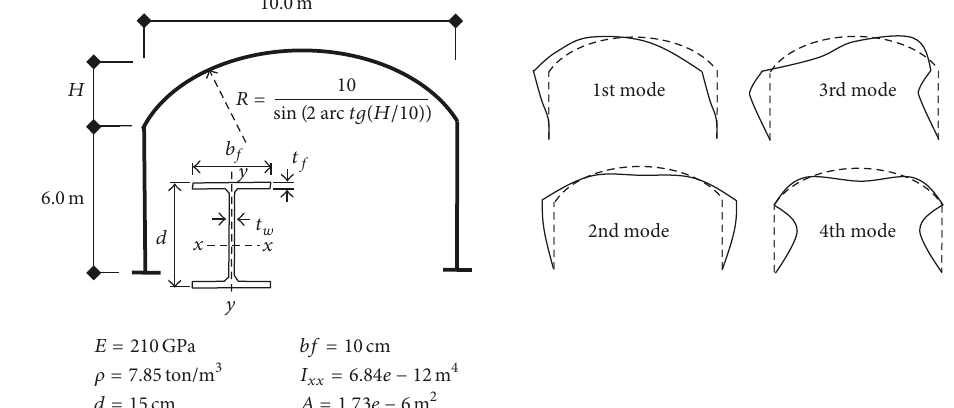
Figure 9: Arched-roof frame model and four first natural vibration modes.